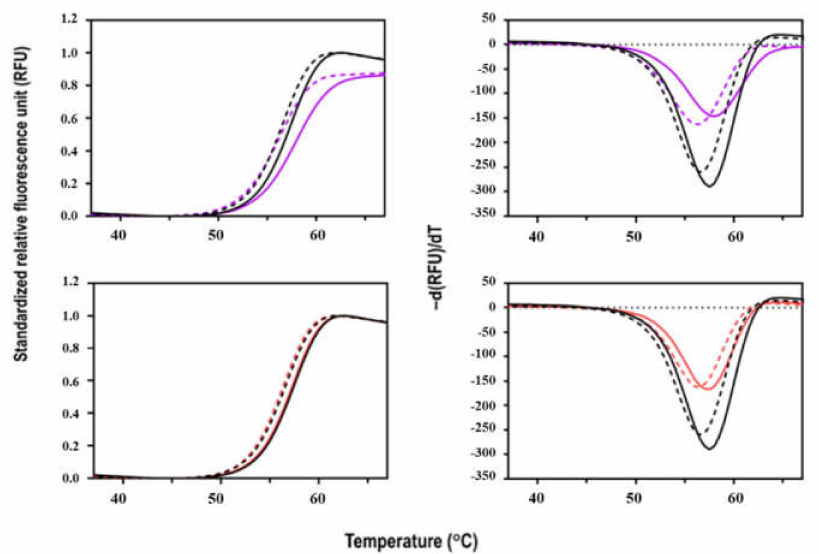
Figure 7. Thermal stability profile of Sbh26GST in the presence and absence of BSP and PZQ. Fluorescence thermal shift assay was carried out in phosphate-buffered saline with and without 1 mM GSH in the presence of Sbh26GST (10 µ g) and Sbh26GST:ligand (10 µ g:5 µ M) combinations. This was screened in 16 replicates, and the data points averaged to generate individual thermal melt curves for data comparison (with the blank subtracted). The left panel shows the standardized RFU vs. temperature ( ◦ C), while the right panel shows the derived - d(RFU)/T vs. temperature ( ◦ C). The position of the minimum indicates the T m ( ◦ C) of each profile. The black dashed profile represents Sbh26GST alone; the bold black profile Sbh26GST:GSH , the dashed purple profile Sbh26GST:BSP , the bold purple profile Sbh26GST:GSH:BSP , the dashed red profile Sbh26GST:PZQ , and the bold red profile Sbh26GST:GSH:PZQ